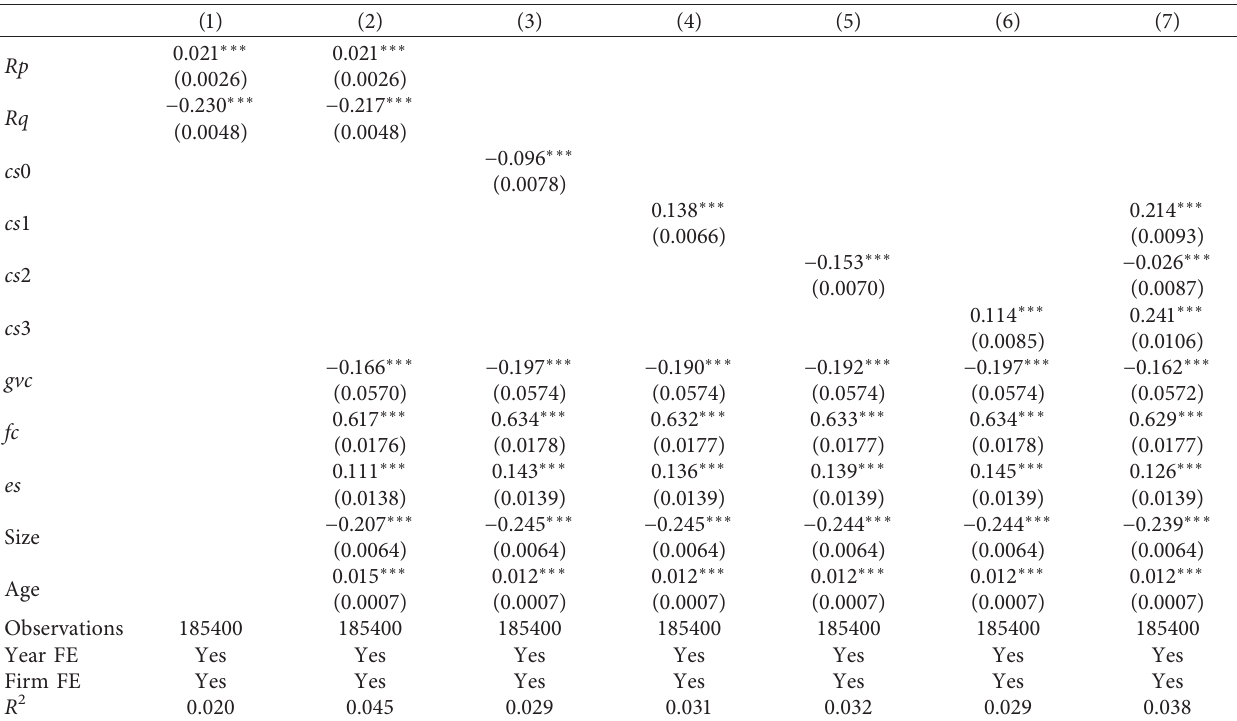
Table 2: Benchmark estimate